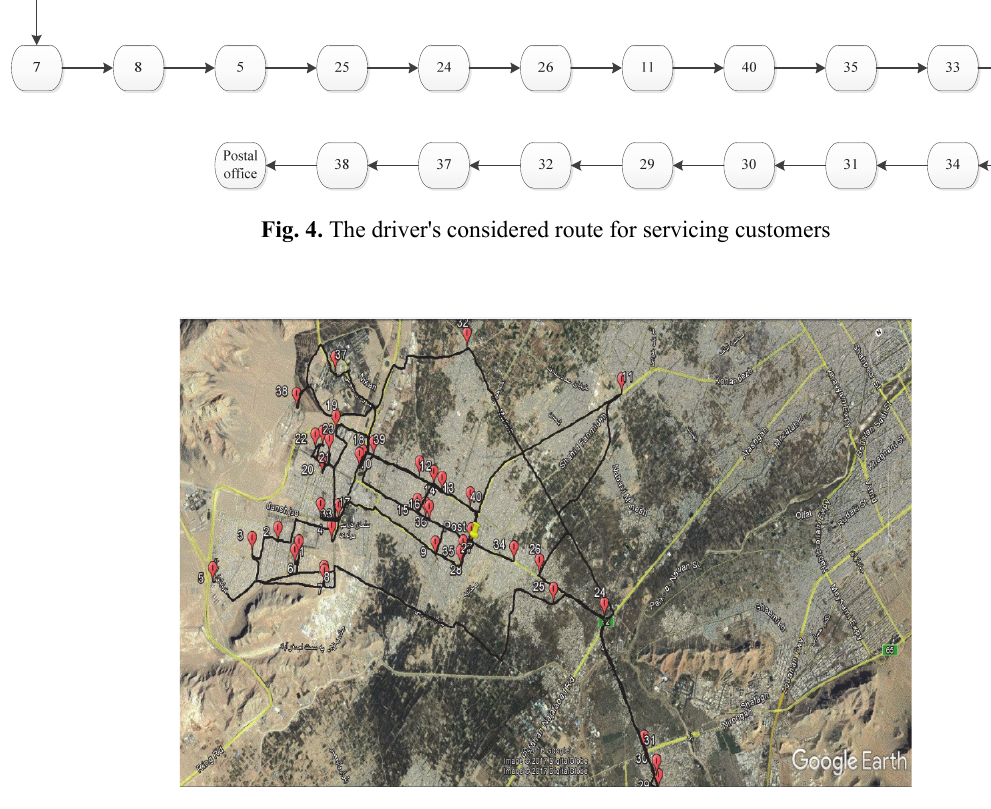
Fig. 5 . Geographical representation of the deriver's considered route for servicing